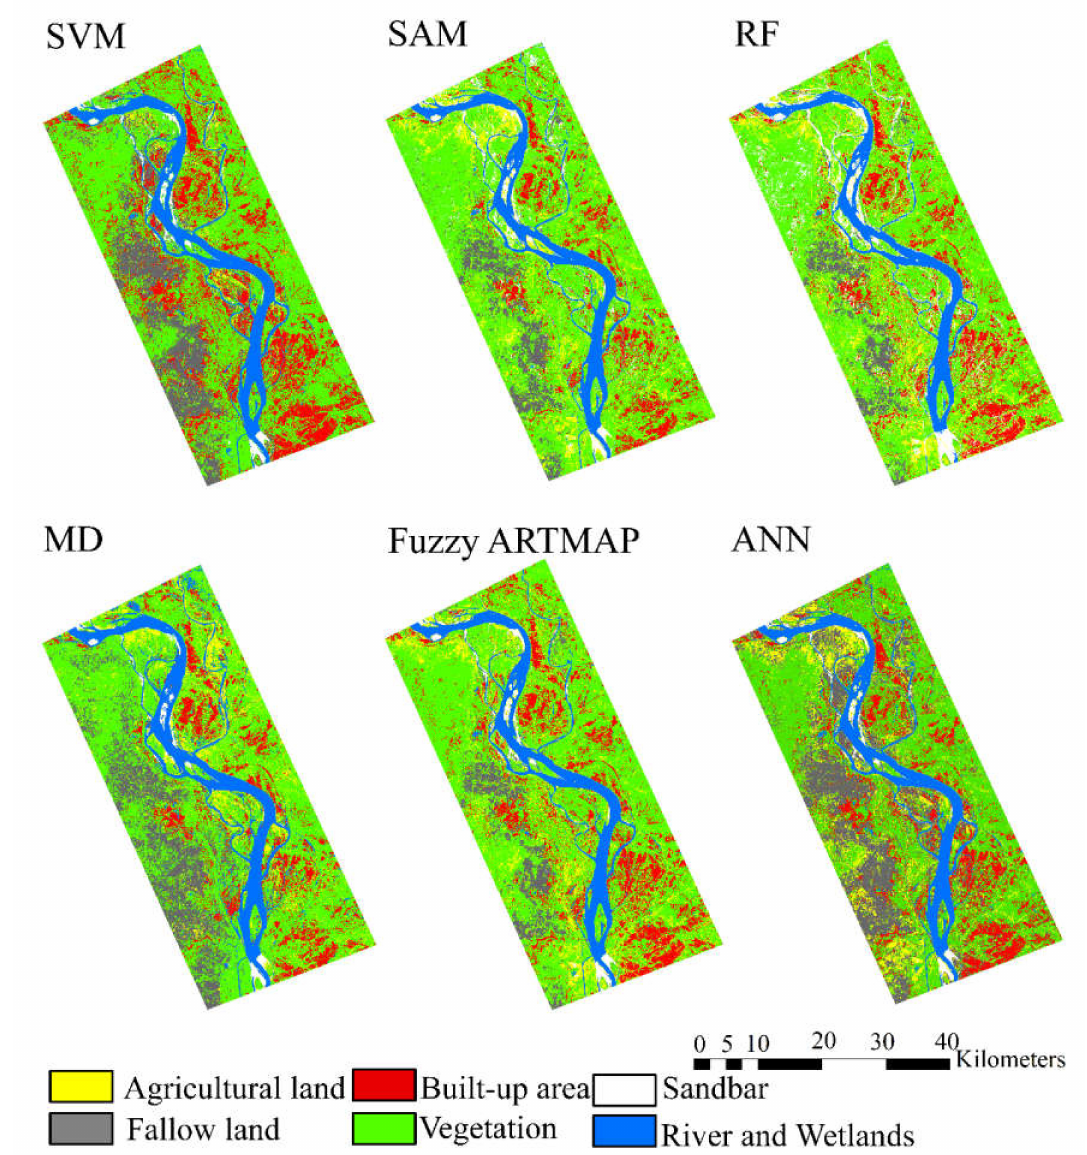
Figure 4. LULC map with di ff erent machine-learning